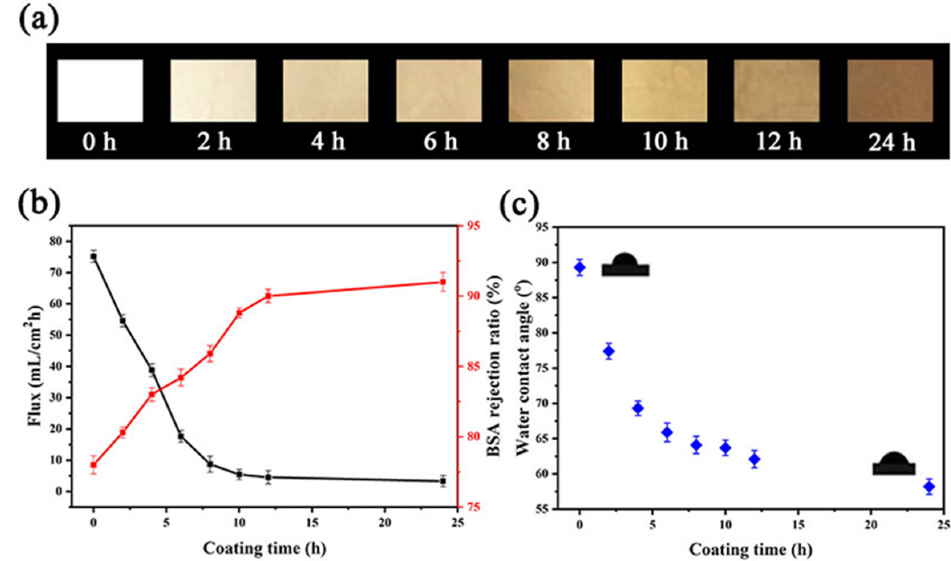
Figure 4. ( a ) Digital photo of iPES membranes with different coating times of PDA; ( b ) Effect of PDA coating time on the water flux and BSA rejection ratio of iPES/PDA composite membrane; ( c ) Effect of PDA coating time on the water contact angle of iPES/PDA composite membrane.